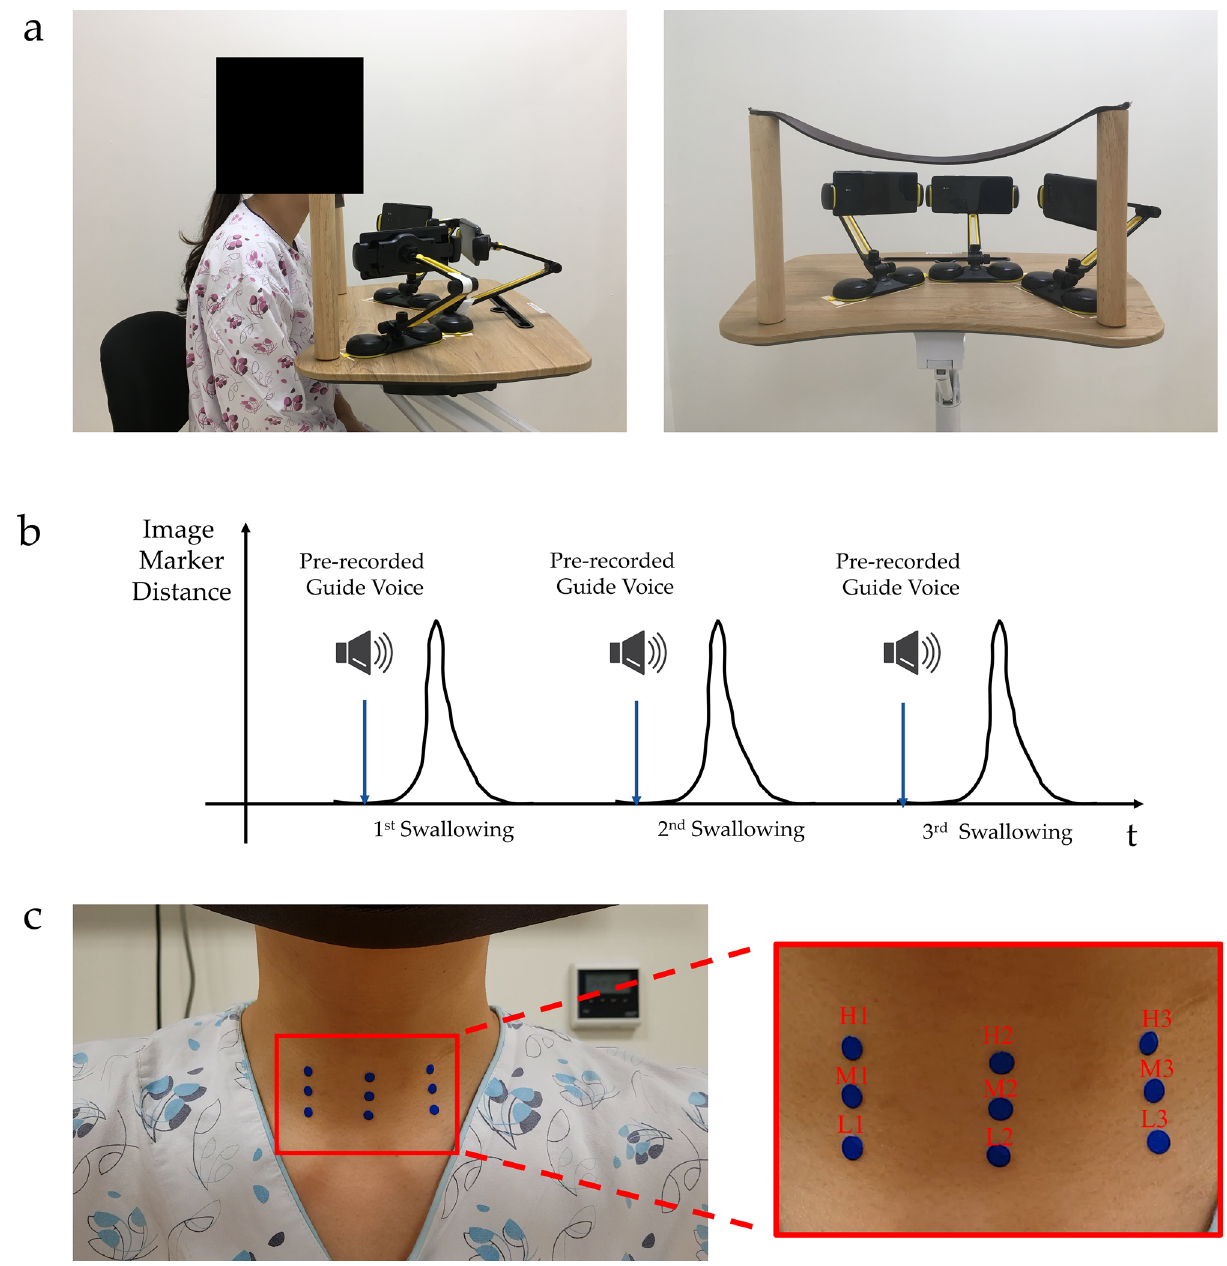
Figure 3. Video recording of a patient. ( a ) Imaging equipment. ( b ) Guidance by the pre-recorded voice. ( c ) Design of the image markers in the recorded